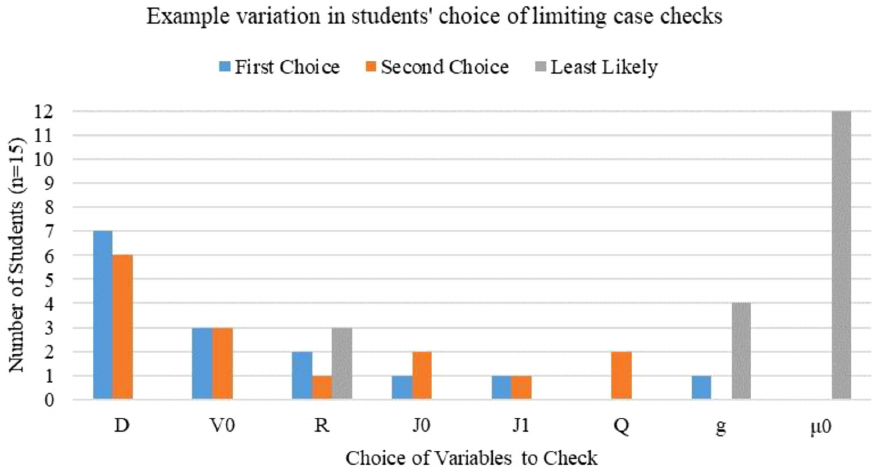
FIG. 5. Summary of student responses to prompts related to Fig. 4, asking which symbols they would check first and second, and which they would be least likely to